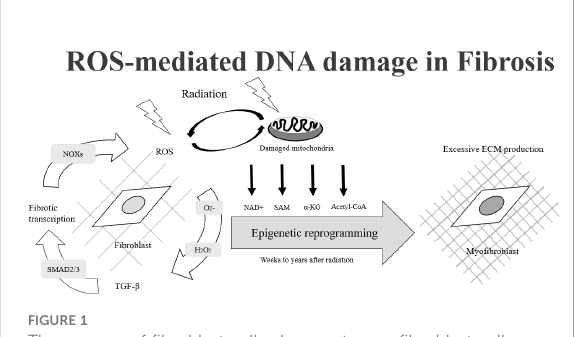
FIGURE 1 The process of fi broblast cells changes to myo fi broblast cells due to ROS-mediated DNA damage.